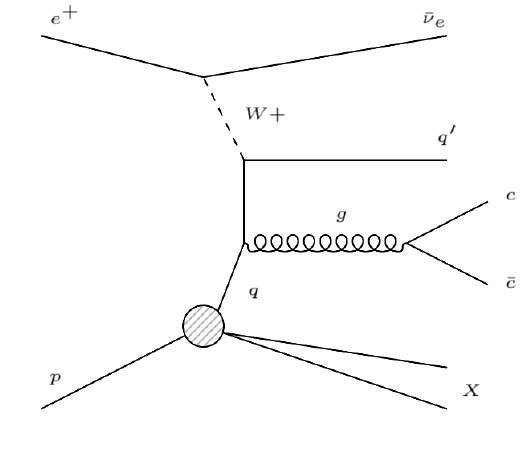
Figure 2. Example Feynman diagram of QCD charm process. The c (cid:22) c pairs from the (cid:12)nal-state gluons, illustrated in the (cid:12)gure, are referred to as QCD charm in the